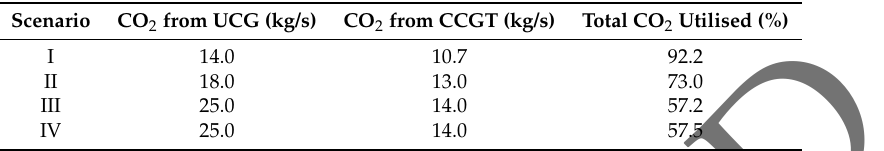
Table 20. Total CO 2 produced (UCG and electricity generation) and its percentage share utilised for methanol synthesis in the four investigated scenarios.